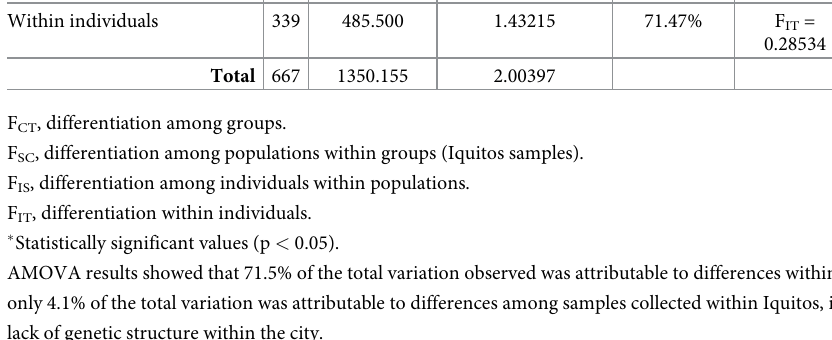
Table 4. Analysis of Molecular Variance (AMOVA) of Ae . aegypti mosquitoes using 8 microsatellite loci. Source of Variation df Sum of Among groups Among populations within groups